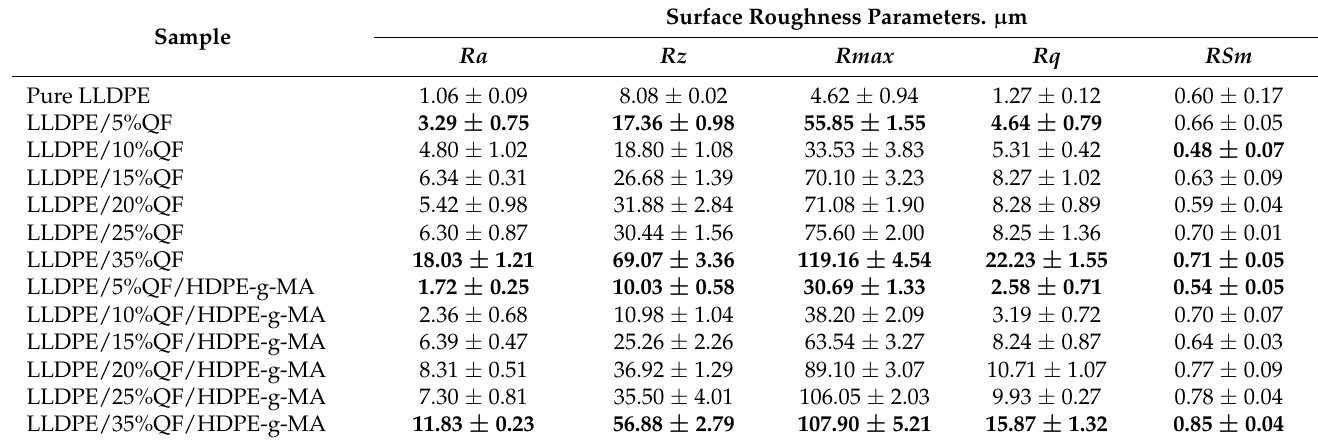
Table 6. Surface roughness parameters of the tested thin-walled moulded parts.